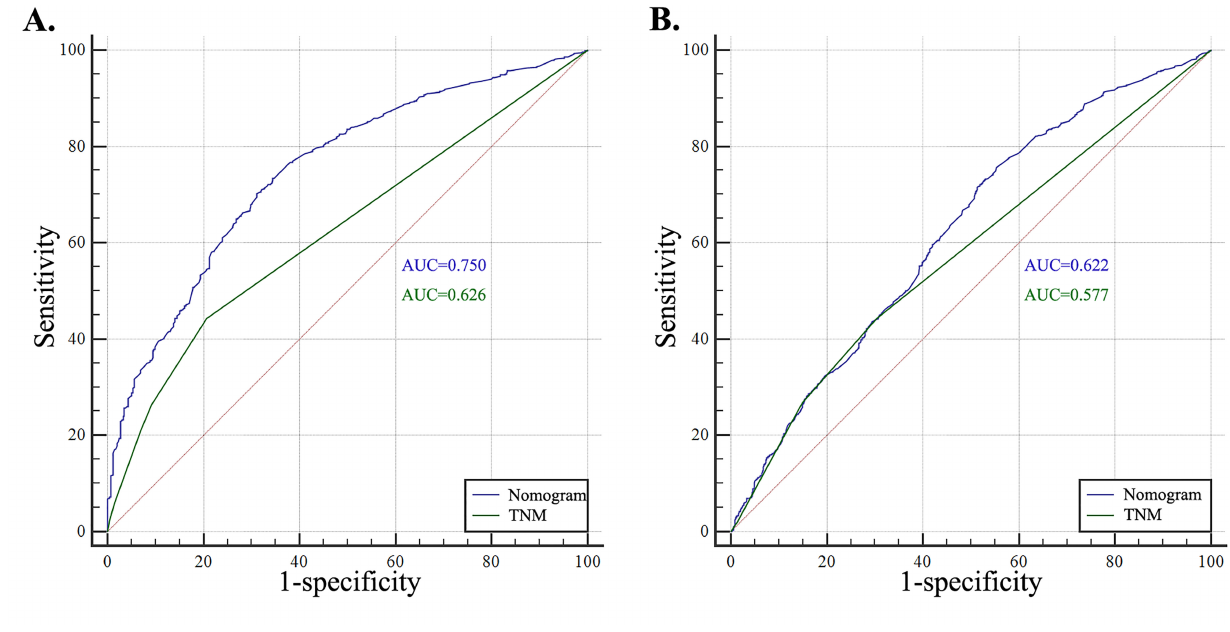
Figure 6 - Receiver operating characteristic (ROC) analysis based on nomograms and TNM-stage. (A) The ROC analysis of OS; (B) The ROC analysis of CSS.